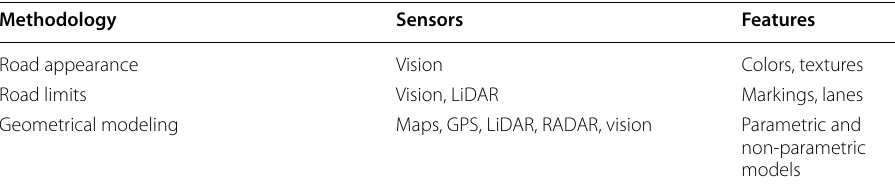
Table 1 Different road detection